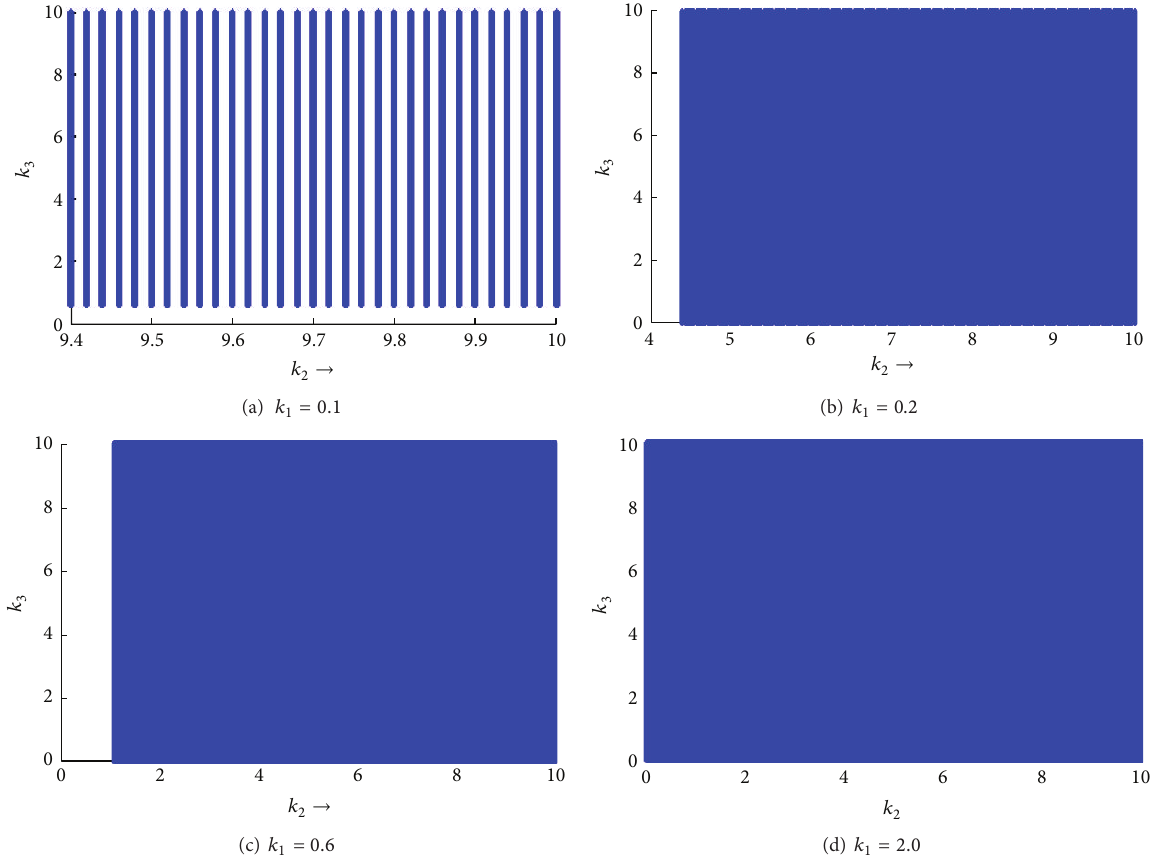
Figure 1: Region of “controllability” for different fixed values of 𝑘 1